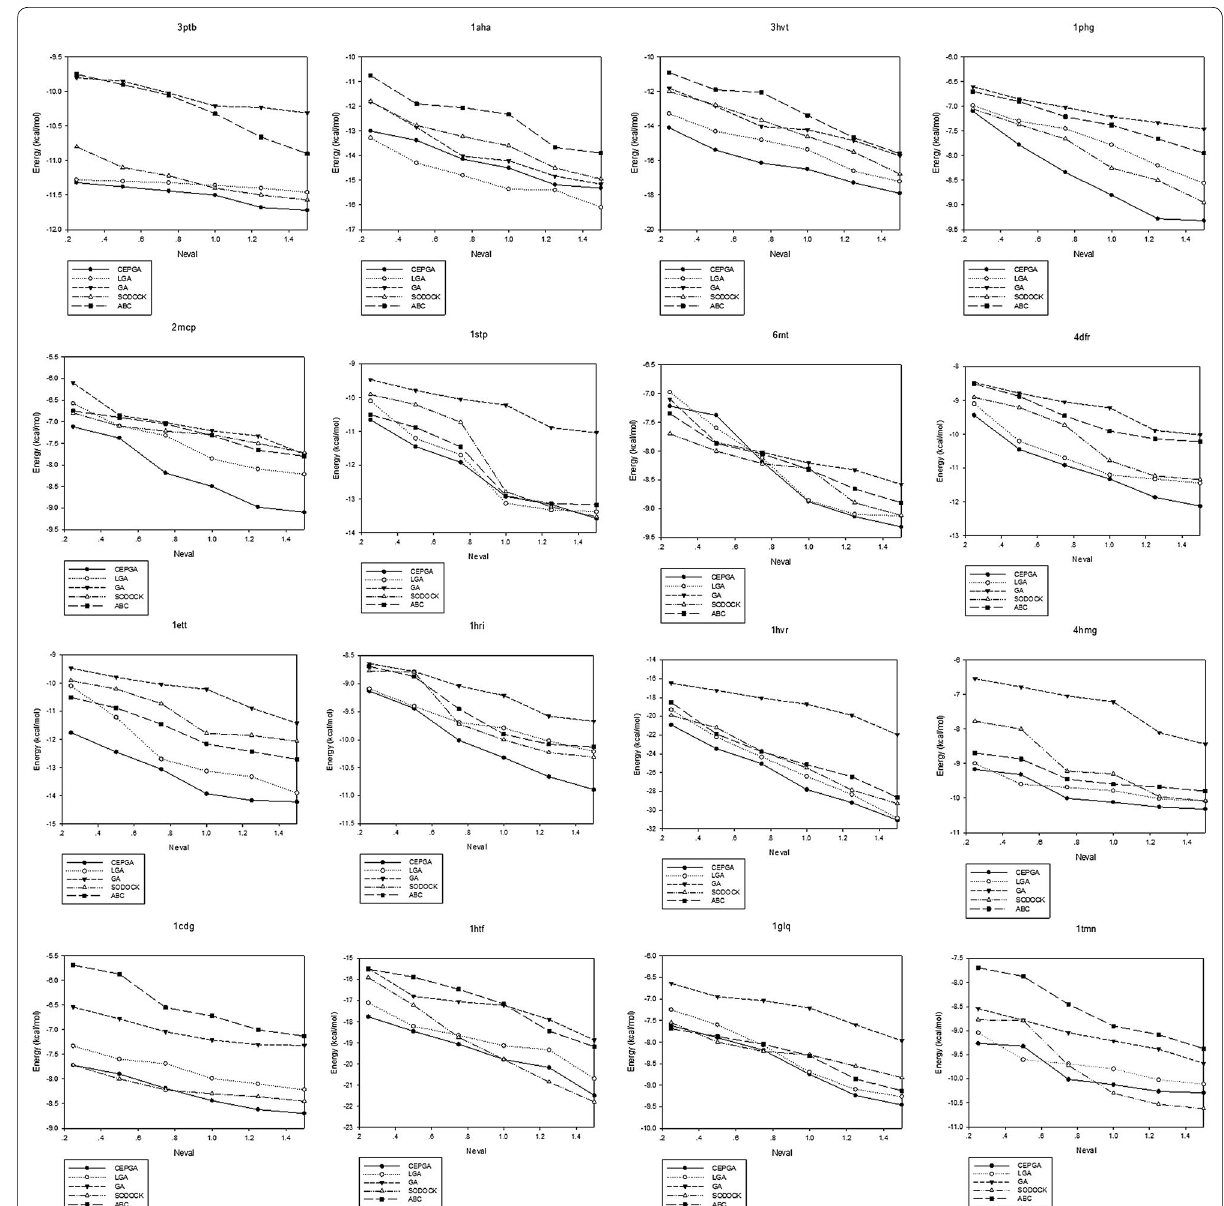
Fig. 3 Convergence diagrams of five algorithms in different PDB. The energy is used as the vertical axis and the number of energy evaluations Neval is used as the horizontal axis. The energy values of different Neval are